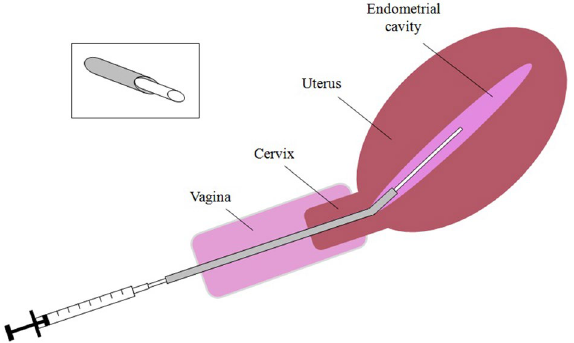
Figure 1. The double-lumen catheter used for endometrial sample collection. This type of catheter is commonly used for embryo transfer. The outer hollow catheter (represented in grey) is placed with its distal part just above the internal os of the cervix. Thereafter, the inner catheter (with a smaller diameter, represented in white) can easily pass through the first one, avoiding contacts with the vaginal and cervical mucosae. Once reached the endometrial cavity, endometrial collection of the endometrial fluid can be obtained by gentle traction on the syringe. The box of upper left corner of the figure shows in more details the mechanism of the double-lumen